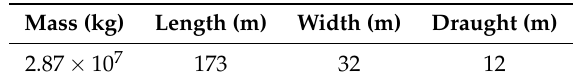
Table 1. Physical characteristics of the ship simulated in this